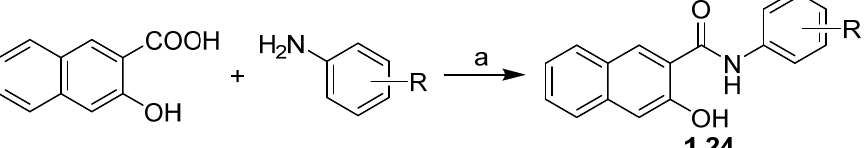
Molecules 2021 , 26 , x FOR PEER